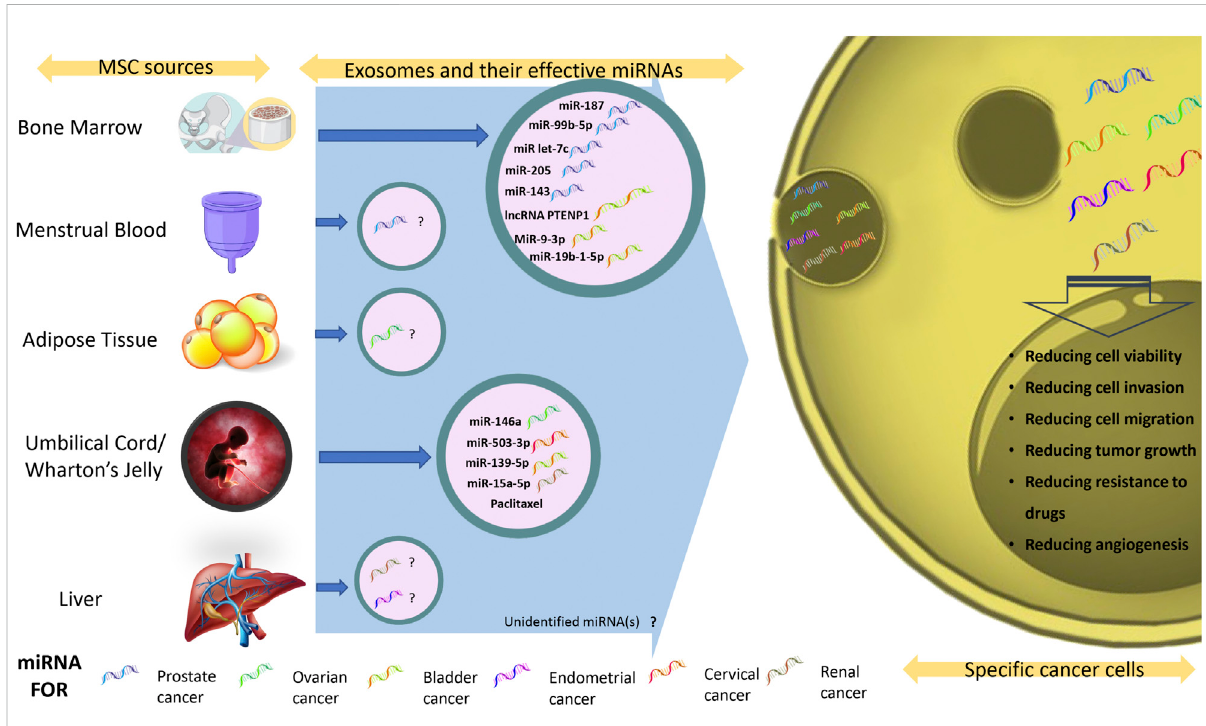
FIGURE 1 ExosomalmiRNAsandtheirtherapeuticeffectsagainstgenitourinaryneoplasms. Summaryofallavailableexosomal miRNAsandtheireffecton genitourinary